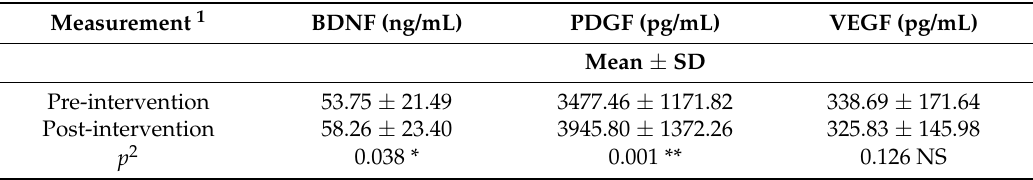
Table 3. The effects of a 20-min gardening activity program on brain nerve growth factor levels in senior individuals ( n =